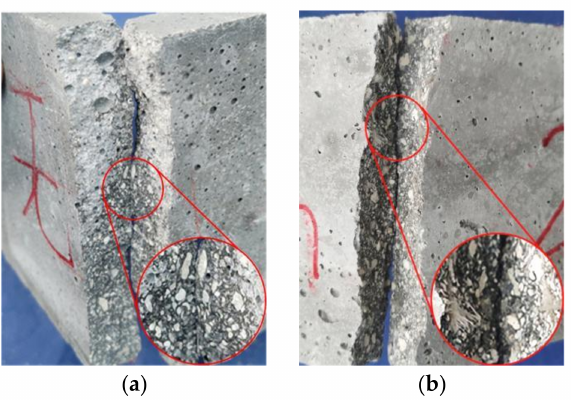
Figure 6. Flexural failure pattern of prismatic specimens. ( a ) NF, ( b ) PVA.